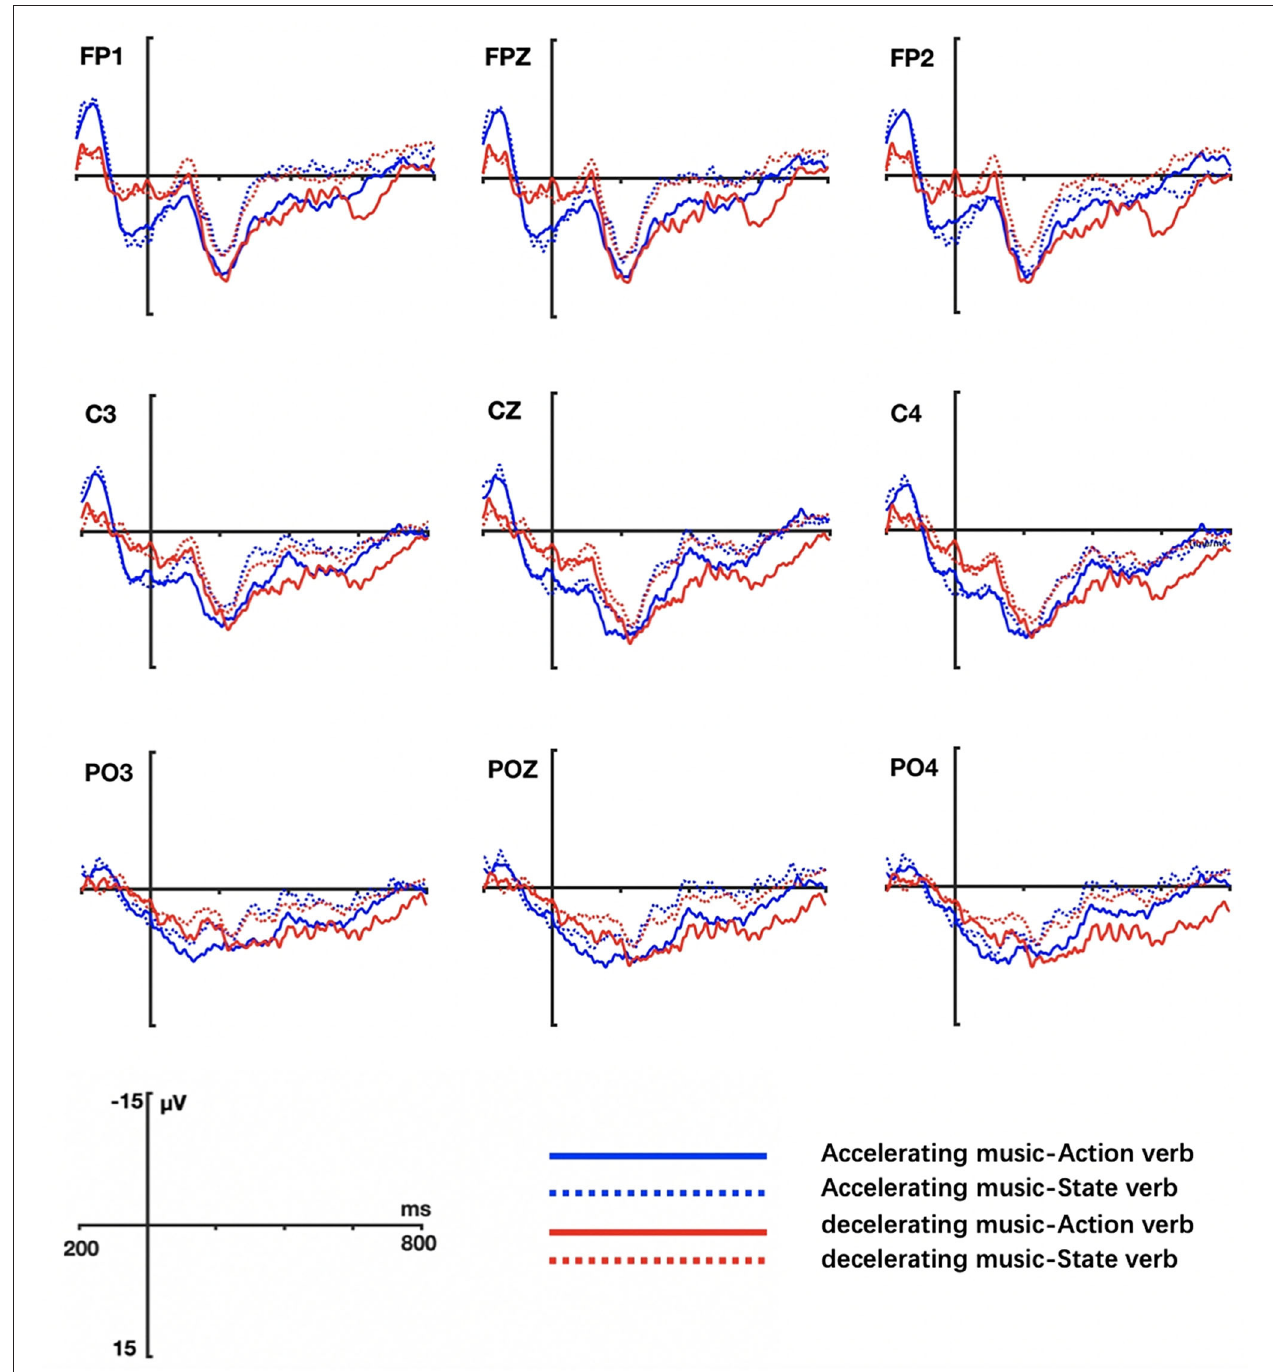
FIGURE 3 | Grand ERP averages elicited by action and state verbs in tempo-with-change music priming conditions (Task